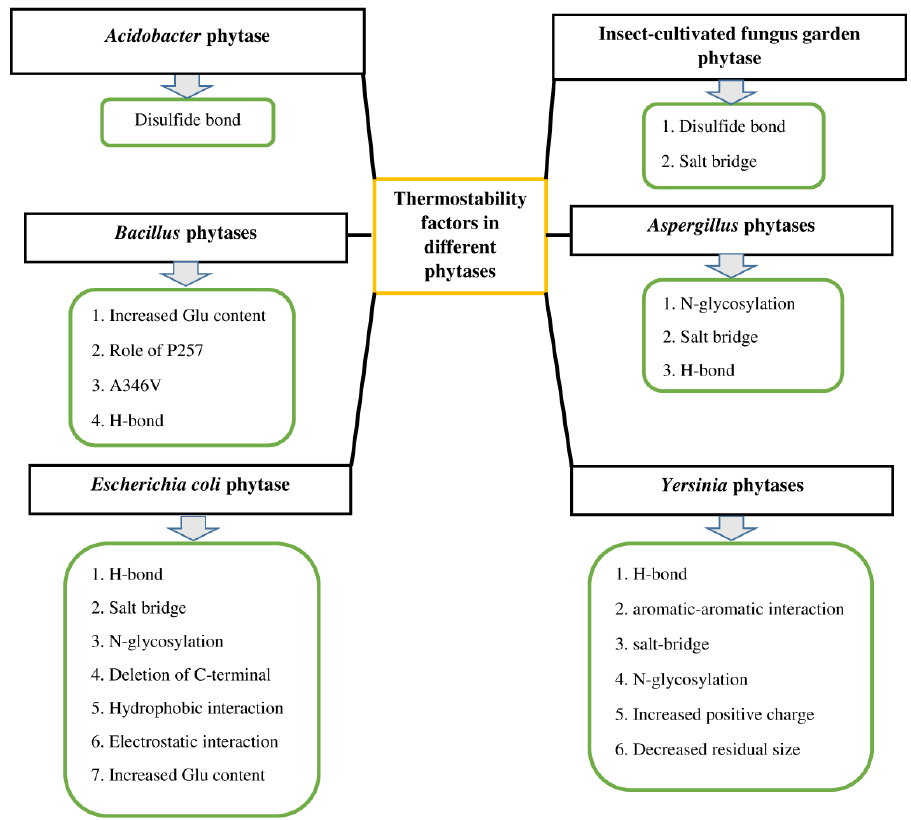
Figure 7. Thermostability factors in phytases from different sources.